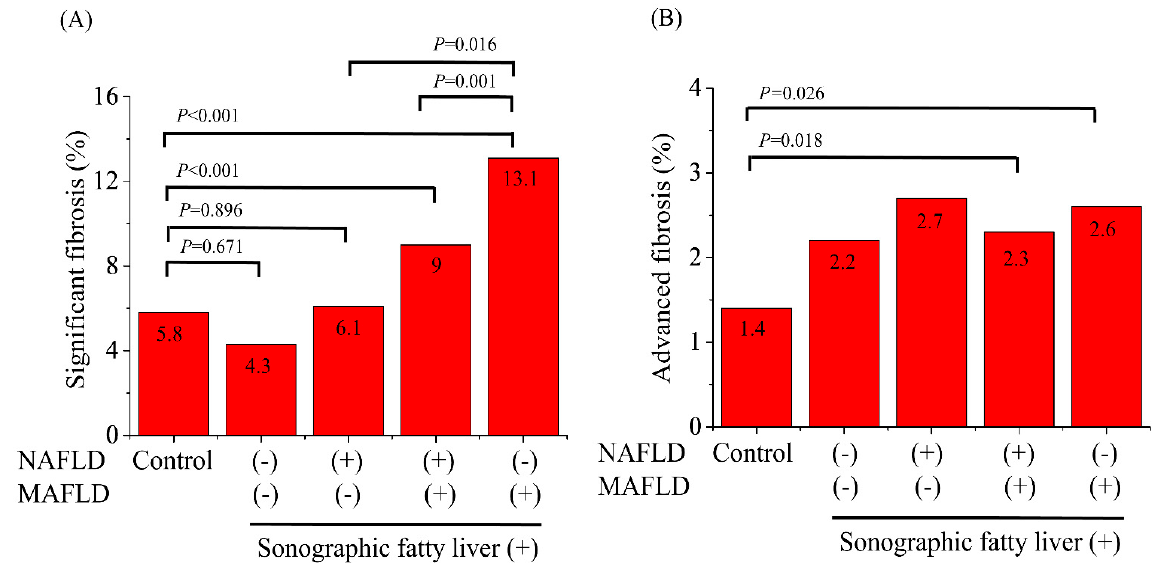
Figure 3. The prevalence of significant fibrosis ( ≥ 3.0 kPa) ( A ) and advanced fibrosis ( ≥ 3.6 kPa) ( B ) on magnetic resonance elastography among the healthy controls, and those with neither NAFLD nor MAFLD, NAFLD only, both NAFLD and MAFLD, and MAFLD only. Abbreviations: MAFLD, metabolic-associated fatty liver disease; NAFLD, non-alcoholic fatty liver